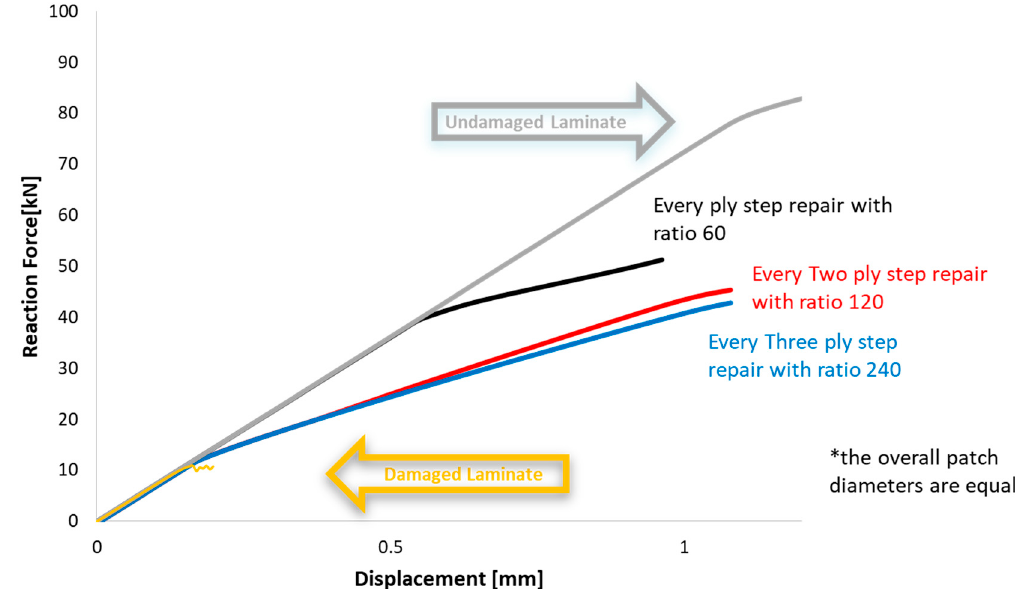
Figure 12. Displacement-Reaction force graph for damaged, undamaged and various repaired laminates with equal overall patch diameter.